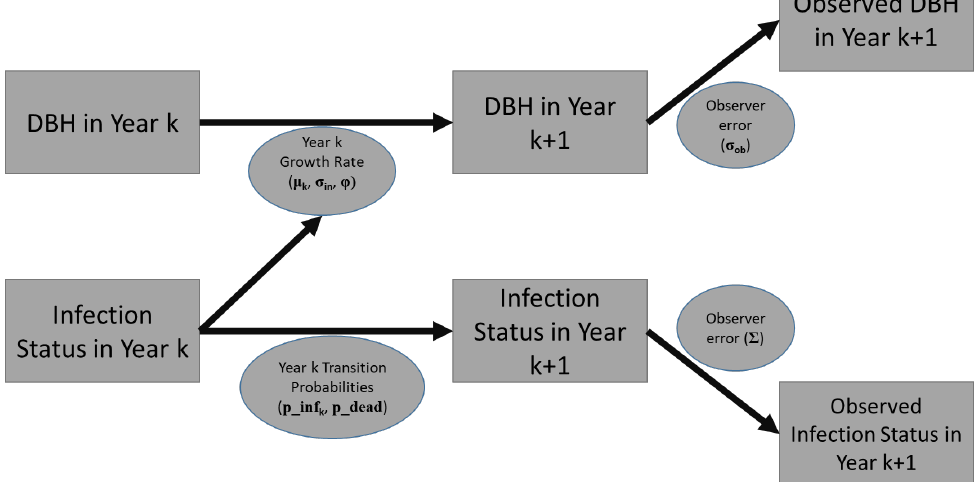
Figure 2. Process model for the spread of BBD and its impact upon radial tree growth. The diagram also shows the relationship between latent and observed values. Table 1. Model variables and